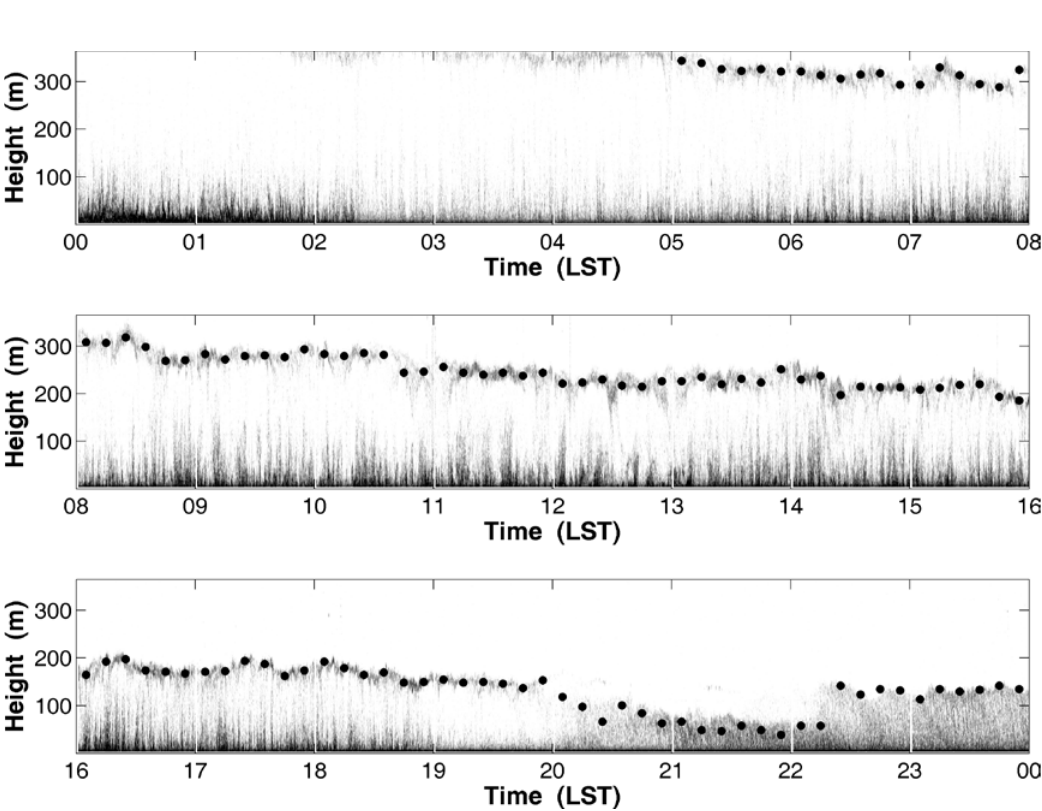
Figure 5 . Sodargram for 10 January 2012 with the mixing height estimate